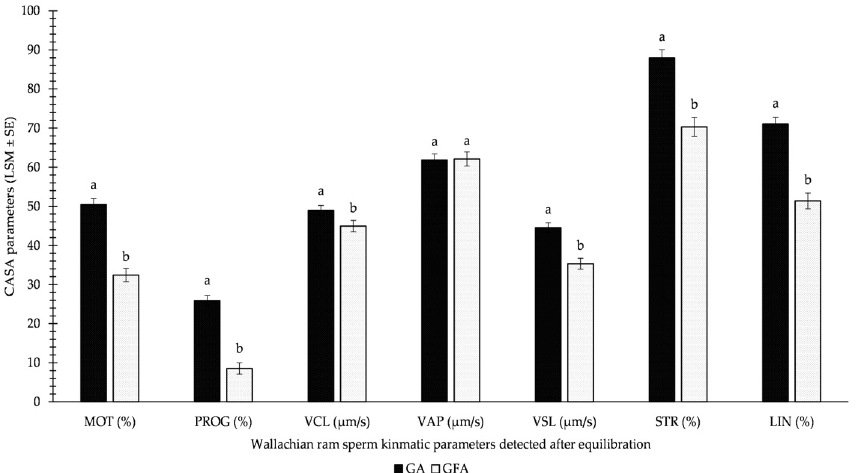
Figure 2. Influence of GA (glycerolation during the whole equilibration process) vs. GFA (glycerola- tion 10 min before the freezing procedure) on CASA parameters in Wallachian ram sperm detected immediately after equilibration; MOT: total motility; PROG: progressive motility; VCL: curvilinear velocity; VAP: average path velocity; VSL: straight-line velocity; STR: straightness; LIN: linearity; a–b: different letters within particular parameters indicate significant differences at a p < 0.05 level of significance.